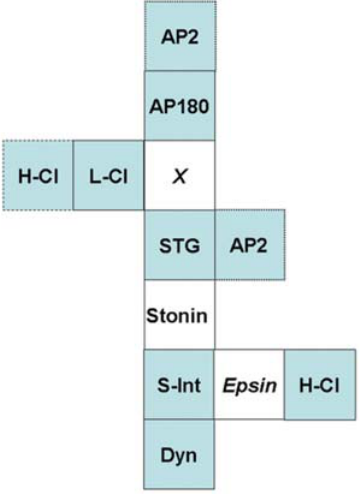
Figure 6. Consensus model for SAE. Model based on Fig. 3 Aiii,B,C and D with stonin2. H-Clathrin is most likely located abutting eprin